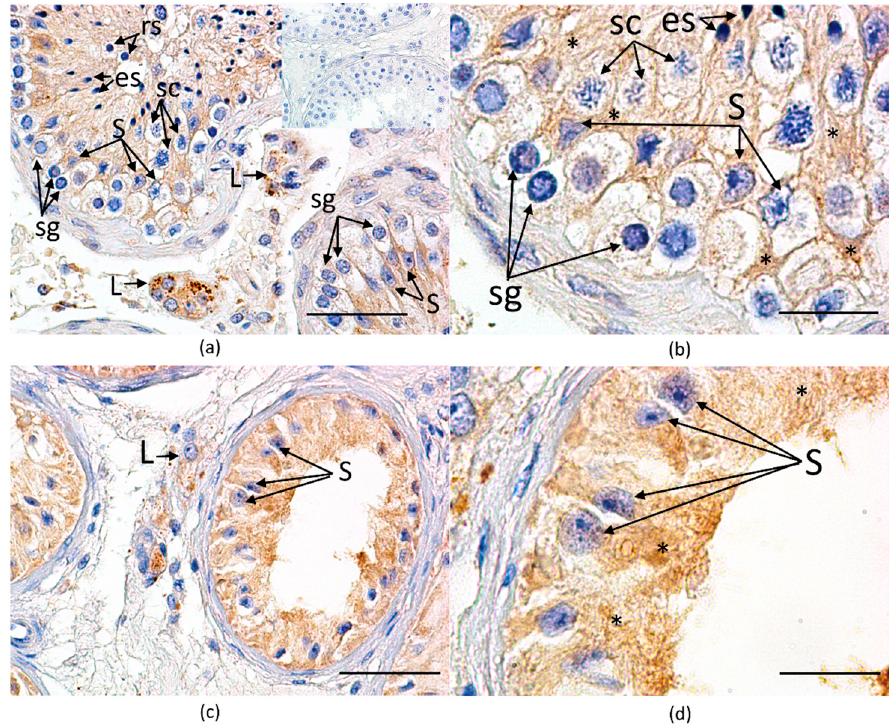
Figure 4. Representative microphotographs presenting immunohistochemical staining of GPER in histological specimens from ( a ) men with obstructive azoospermia presenting complete spermatogenesis (CS); and ( c ) from men with non-obstructive azoospermia presenting Sertoli cell-only syndrome; insert in ( a )—negative control; ( b , d )—higher magnifications of microphotographs ( a , c ), respectively. The color reaction of the studied antigen (GPER) is visible as a brown coloration of Leydig and Sertoli cell cytoplasm; L—Leydig cells cluster; S—Sertoli cell nuclei; sg—spermatogonia; sc—spermatocyte; rs—round spermatids; es—elongated spermatids; * — Sertoli cell cytoplasm in ( b , d ). Note the lack of color reaction in the rim of the cytoplasm surrounding nuclei of germ cells ( a , b ); ( a , c )—magnification 400 × , scale bar = 50 µ m; ( b , d )—magnification 1000 × , scale bar = 20